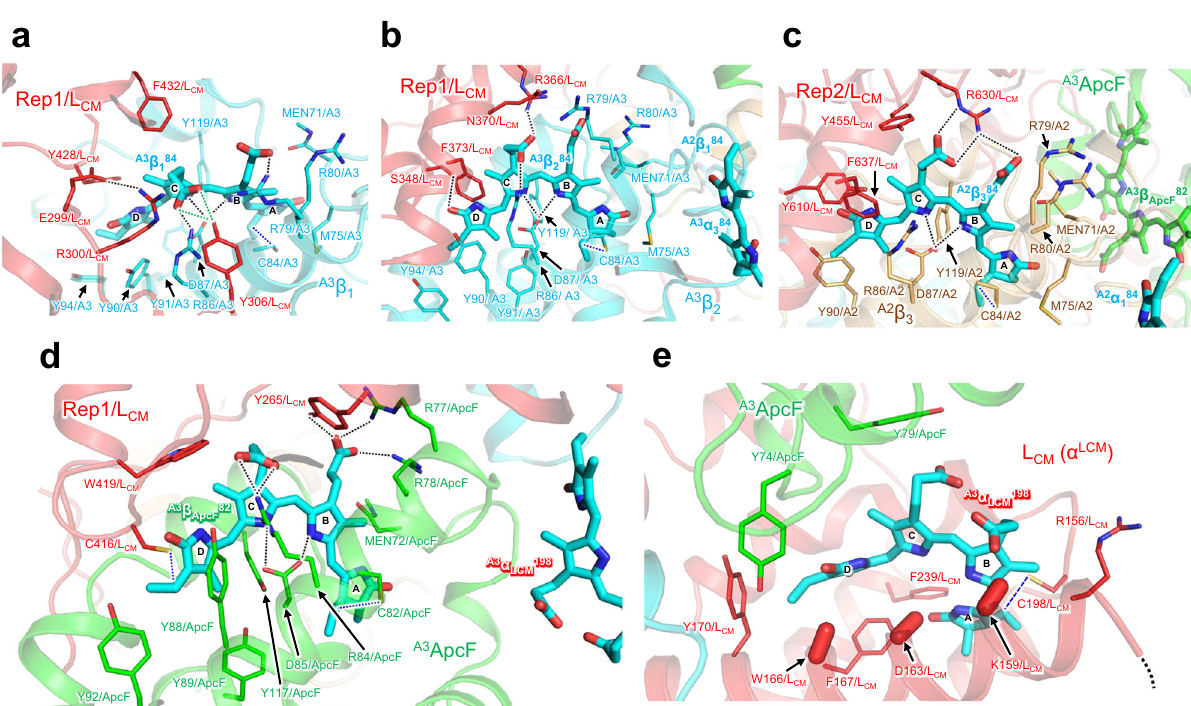
Fig. 4 Chromophores and their surrounding structures in terminal emitter (ApcE [L CM ]) and ApcF. a, b Chromophores in the APC trimer A3 and their interaction with Rep1 of ApcE. c Chromophore in the APC trimer A2 and its interaction with Rep2 of ApcE. d Chromophore of ApcF and its interaction with Rep1 of ApcE. e Chromophore of ApcE and its interaction with ApcF. The dashed lines (black) indicate hydrogen bonds. The dotted lines (blue) indicate covalent bonds between PCB and cysteine residue. Amino acid residues for which the side-chain arrangement cannot be precisely displayed are indicated with capsule-shaped objects. The directions of atoms from C α to C β in the residues are indicated by the capsule-shaped